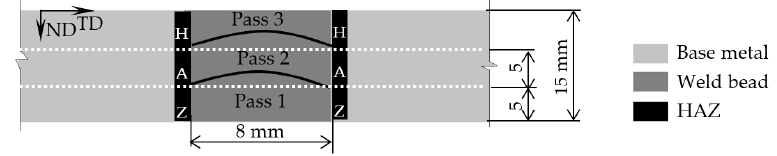
Figure 1. Schematic of HAZ configuration.